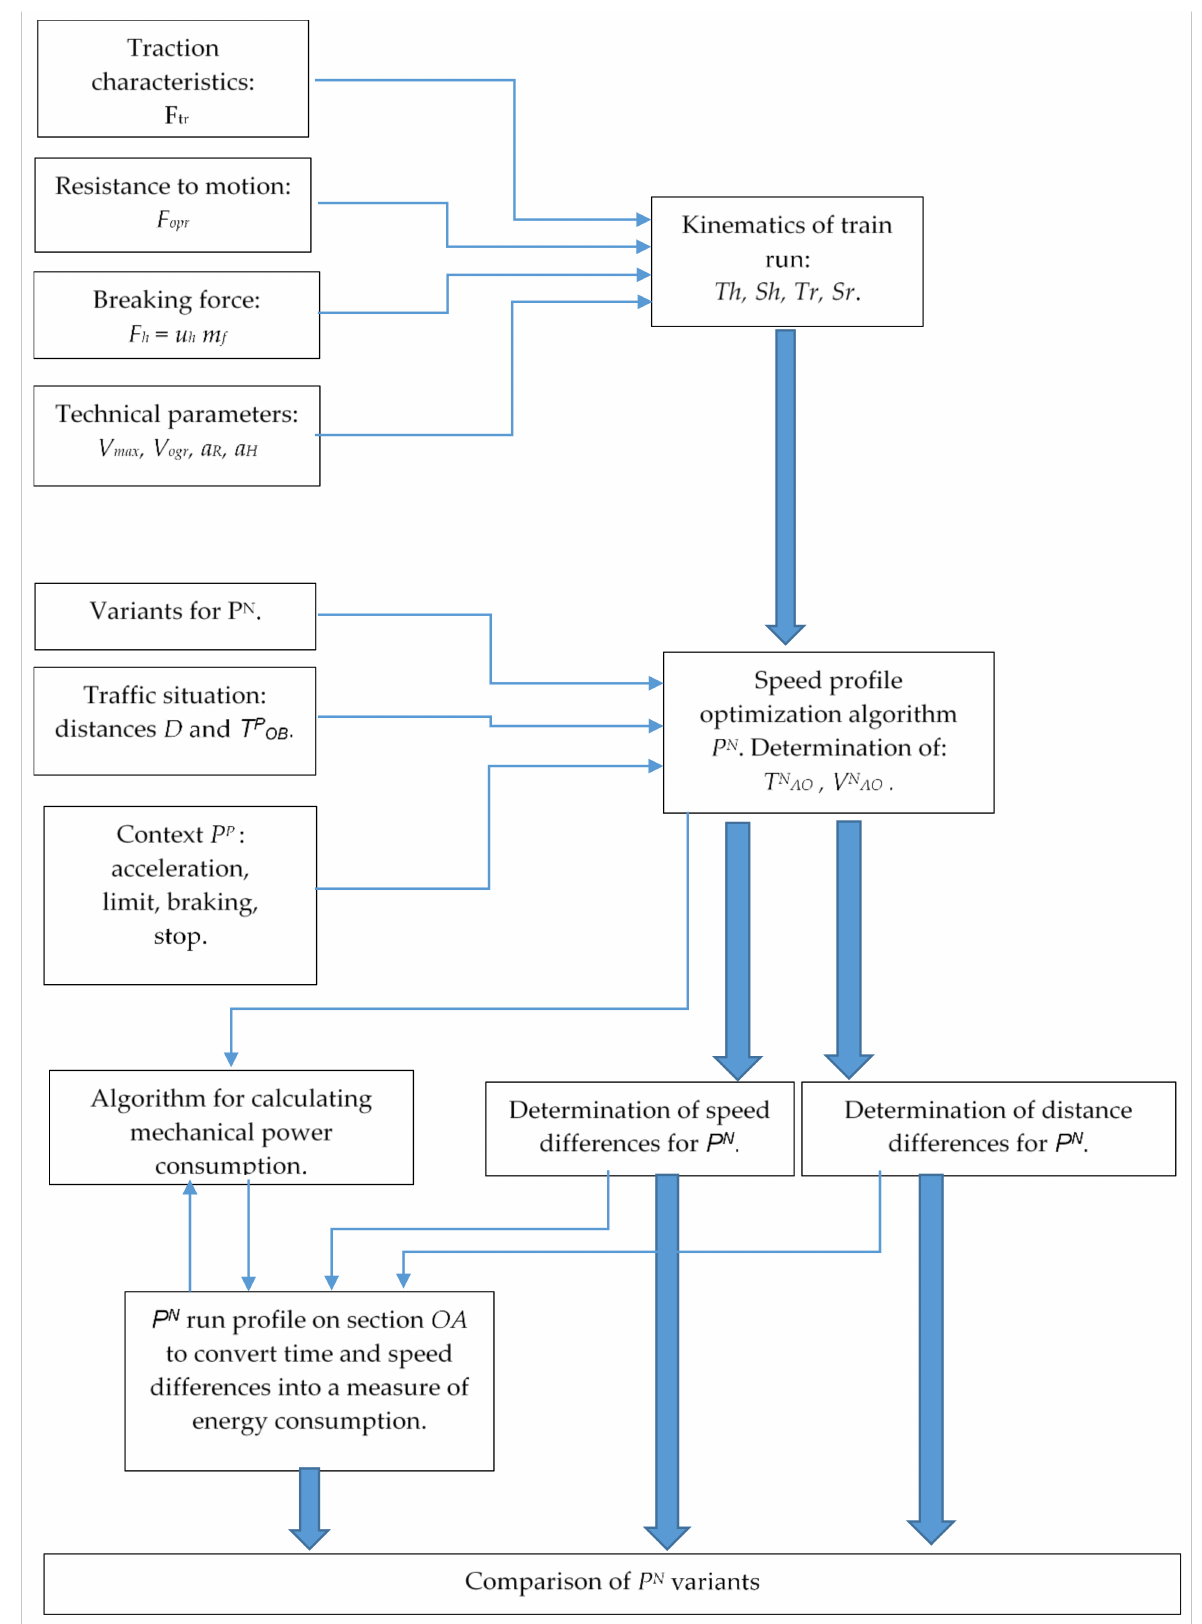
Figure 5. Schematic diagram of the model logic for the simulation implementation (source: own